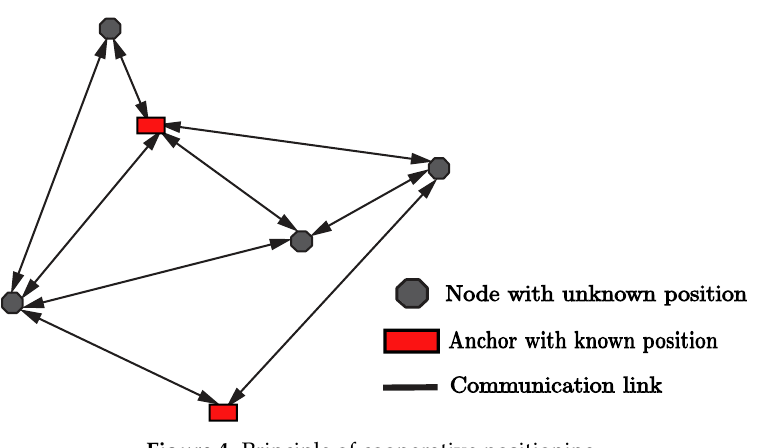
Figure 4. Principle of cooperative positioning.